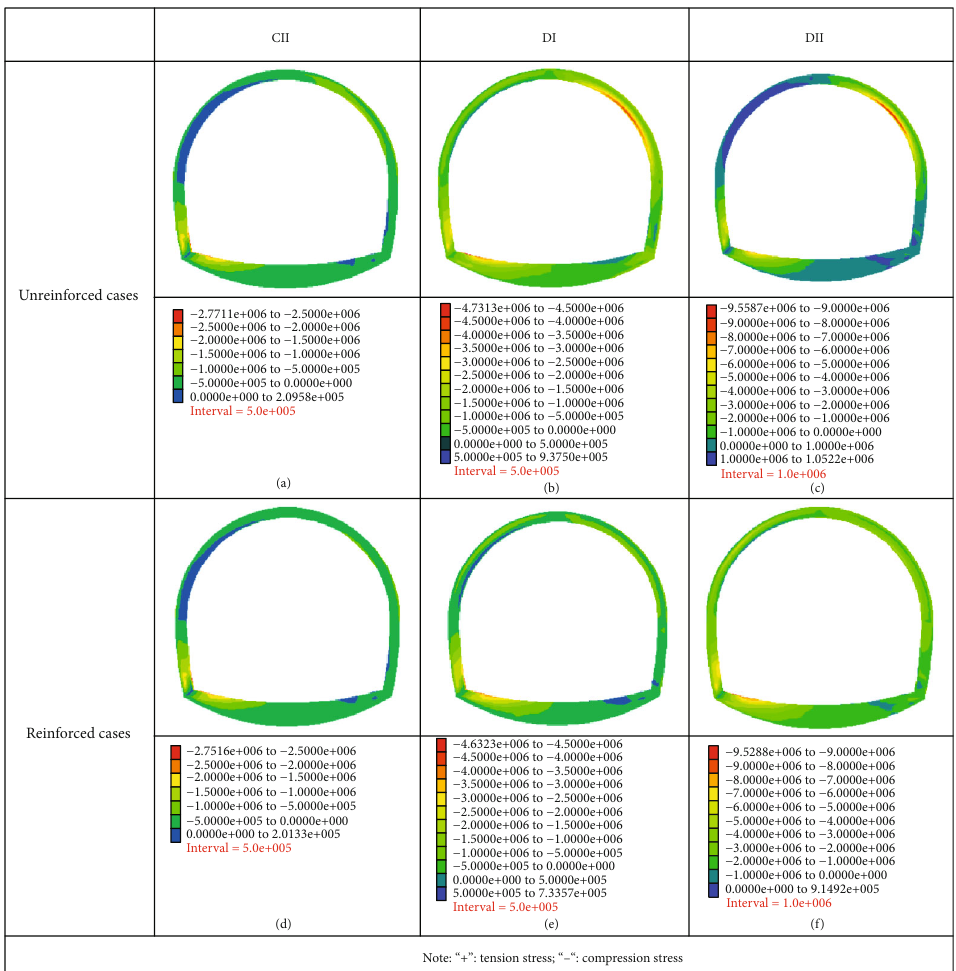
Figure 8: Axial stress distribution on lining concrete for tunnel constructed by NATM (unit: